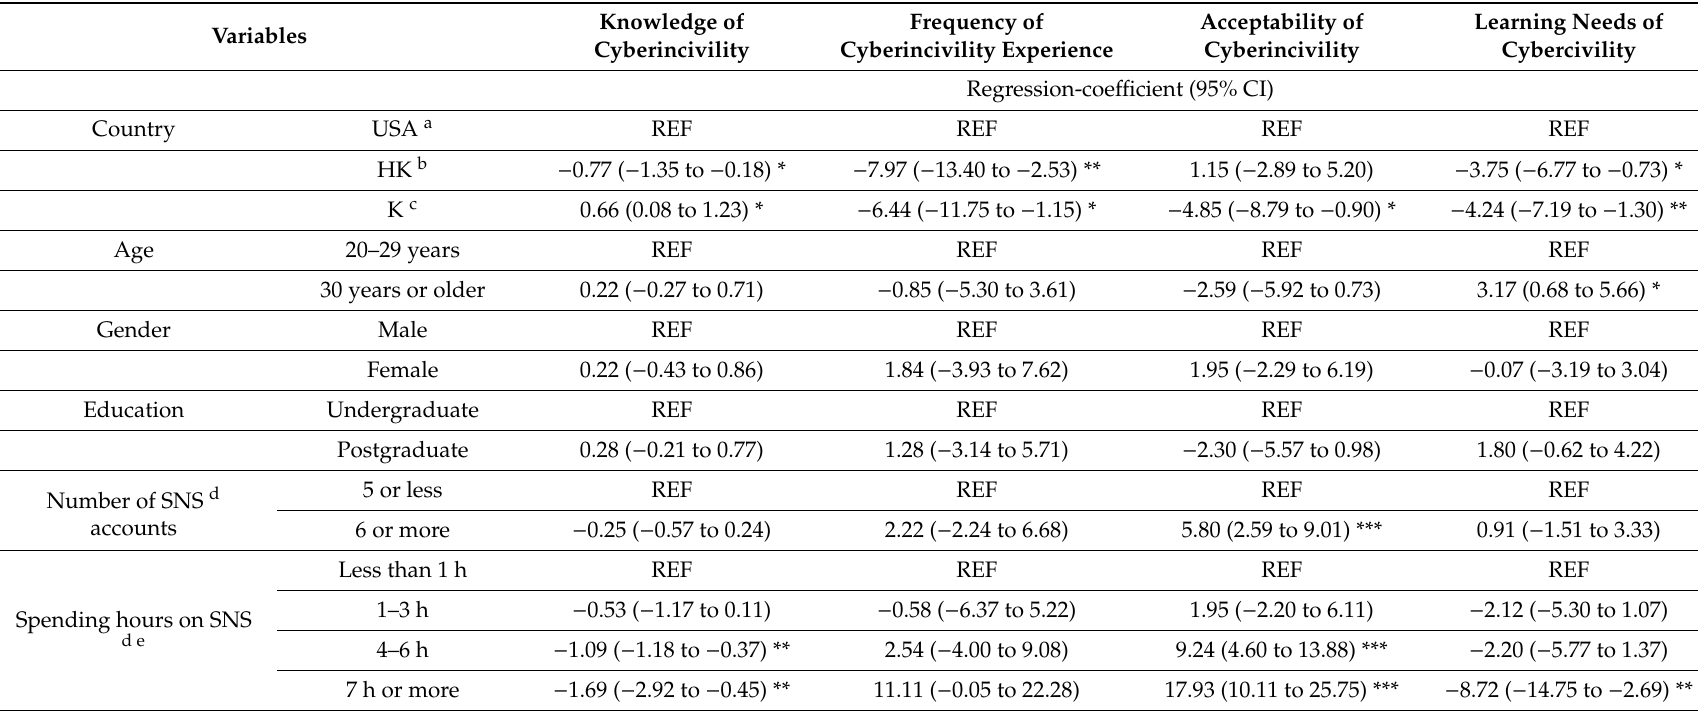
Table 5. Factors associated with cyberincivility among respondents in linear regression